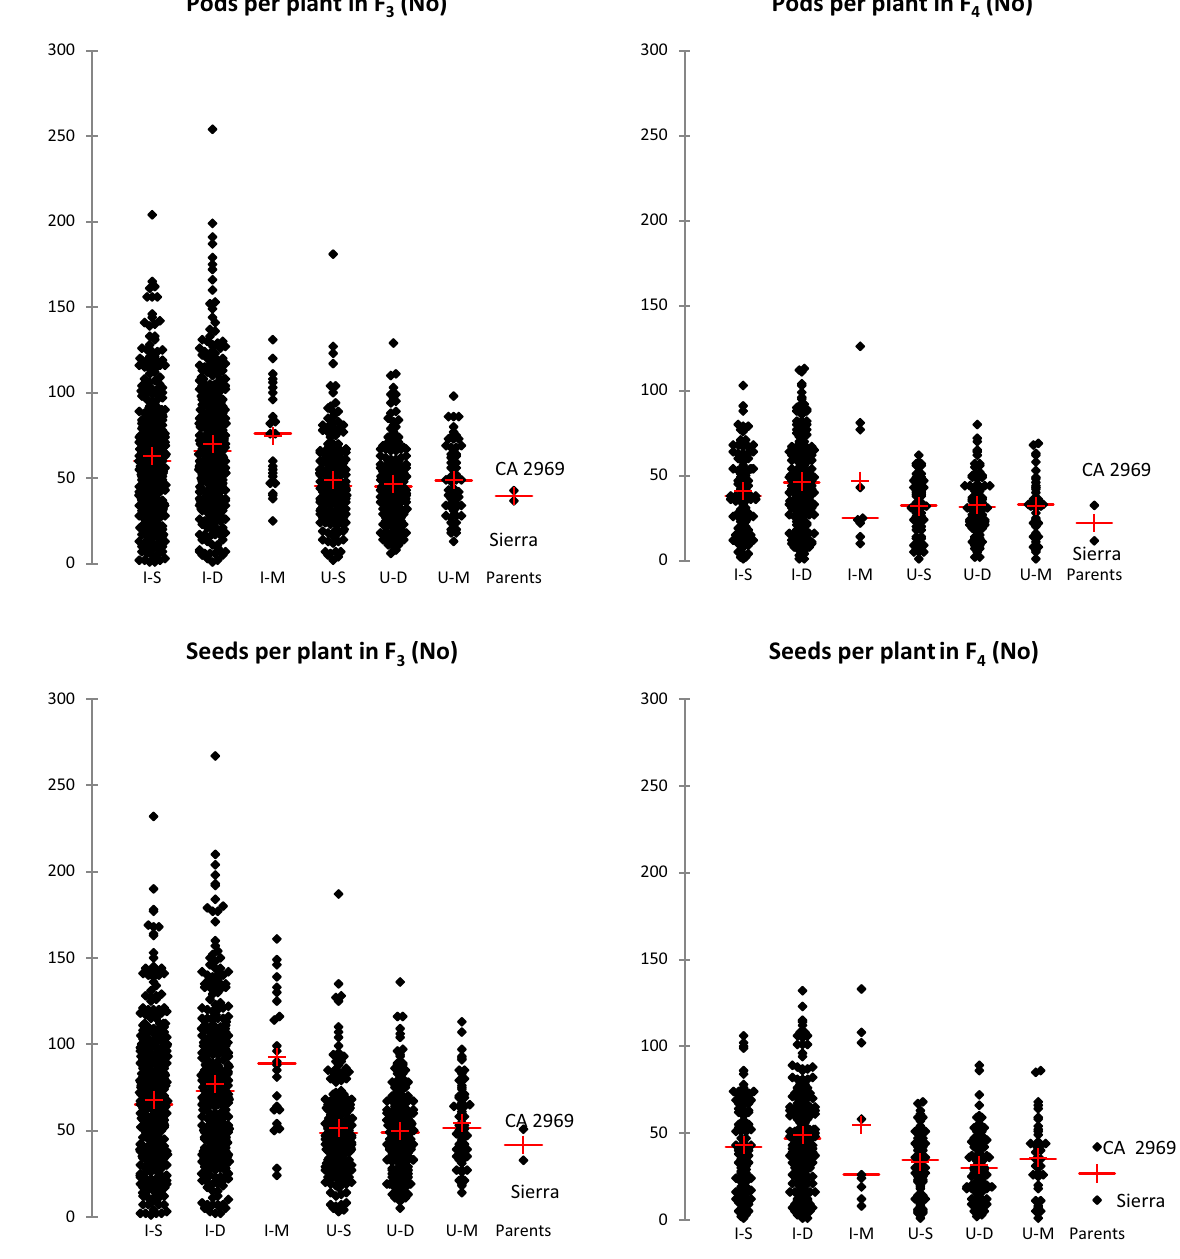
Figure 2. Means (+) of transgressive segregations and superior lines for pods and seeds per plant in F 3 and F 4 populations derived from intraspecific crosses between Sierra and CA 2969. Each dot represents a progeny. I–S: imparipinnate-leafed and single-podded progeny, I–D: imparipinnate-leafed and double-podded progeny, I–M: imparipinnate-leafed and multi-podded progeny, U–S: unifoliolate-leafed and single-podded progeny, U–D: unifoliolate-leafed and double-podded progeny, U–M: unifoliolate-leafed and multi-podded